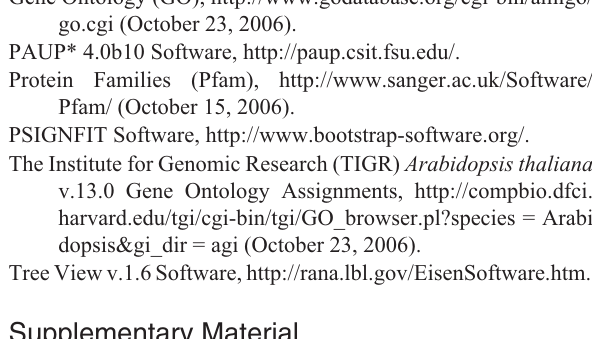
Table 1S- Citrus reads constituting contigs and singlets with homology to genes involved in the input path- way to the circadian clock in Arabidopsis thaliana . Table 2S - Citrus reads constituting contigs and sin- glets with homology to genes involved in the central oscil - lator of the circadian clock in Arabidopsis thaliana . Table 3S - Citrus reads constituting contigs and sin- glets with homology to genes involved in the integration of the circadian clock mechanism and the generation of output responses in Arabidopsis thaliana